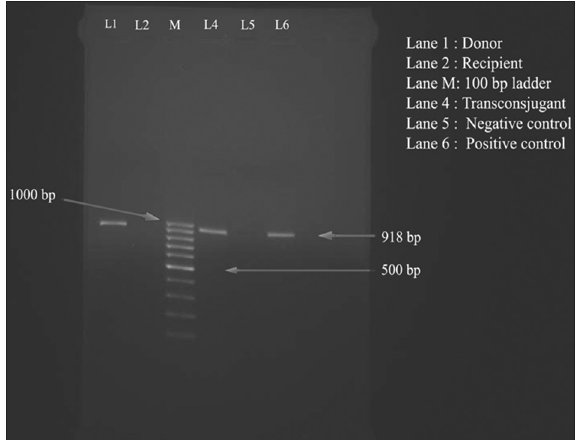
Figure-3: Polymerase chain reaction assay for detection of ( bla ) gene (918 bp) in transconjugant for confirmation TEM of horizontal gene transfer conjugation. Lane 1: Donor; Lane 2: Recipient; Lane M: 100 bp DNA ladder; Lane 4: Transconjugant; Lane 5: Negative control; and Lane 6: Positive